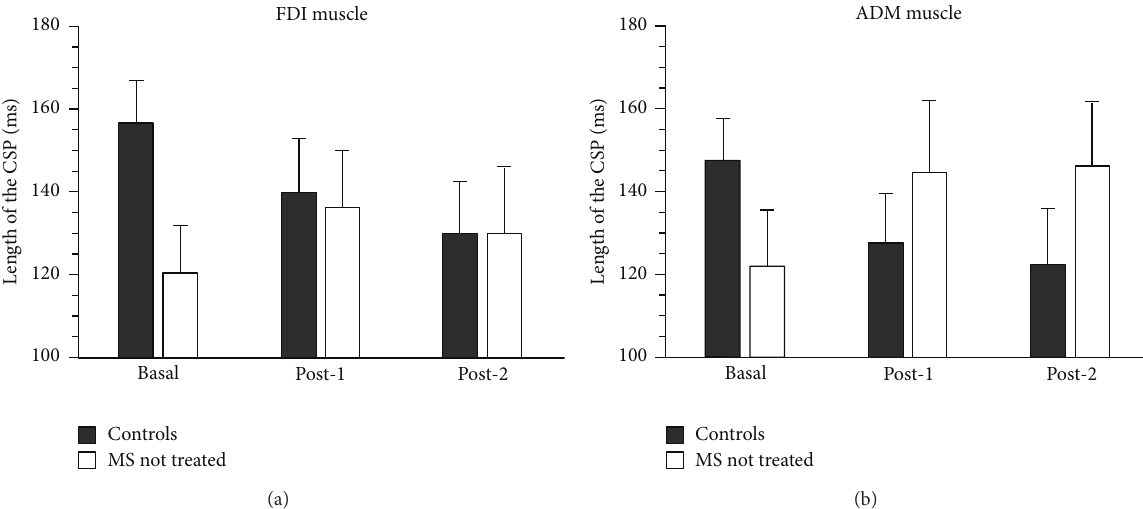
Figure 2: Histograms represent the mean ( ± SE) duration of the cortical silent period (CSP) from the FDI muscle (a) and ADM muscle (b) in basal conditions and following two progressively fatiguing tasks (Post-1 and Post-2) both in controls and in MS patients before amantadine treatment. Statistics of the repeated measures ANOVA are reported in the text.